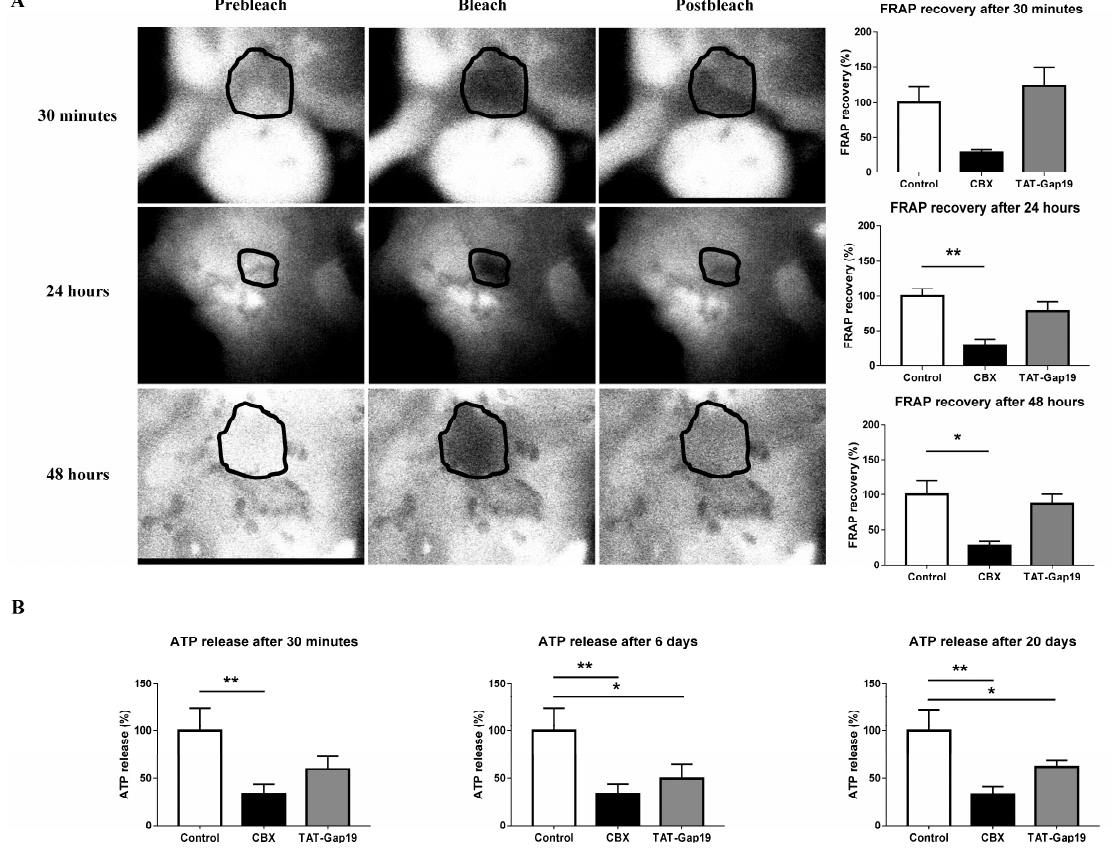
Figure 1. Effects of carbenoxolone (CBX) and transactivator of transcription (TAT)-Gap19 on gap junctions (GJs), and hemichannels in cultures of primary rat hepatocytes. Primary rat hepatocytes were exposed to 50 μ M CBX, 20 μ M TAT-Gap19, or vehicle control. ( A ) GJ activity was measured through FRAP analysis after 30 min, 24 h and 48 h ( n = 4, N = 4). ( B ) Hemichannel activity was determined by measurement of extracellular ATP release analysis after 30 min ( n =3, N =6). TAT-Gap19 was incubated at 37 ◦ C for 0 min, 6 days, and 20 days in an incubator prior to functionality assessment. Results were analyzed by 1-way ANOVA followed by post hoc Bonferroni correction. Data were expressed as means ± SEM (* p ≤ 0.05; ** p ≤ 0.01).